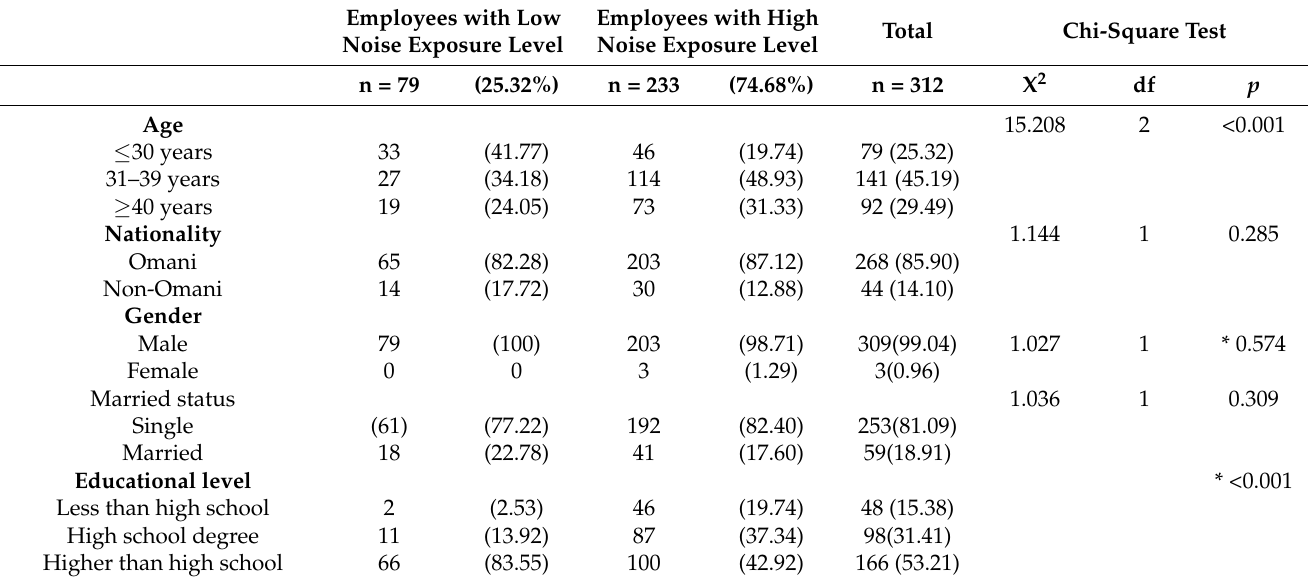
Table 2. Distribution of study participants’ socio-demographic features in relation to their noise exposure level as identified using l TWA measurements.